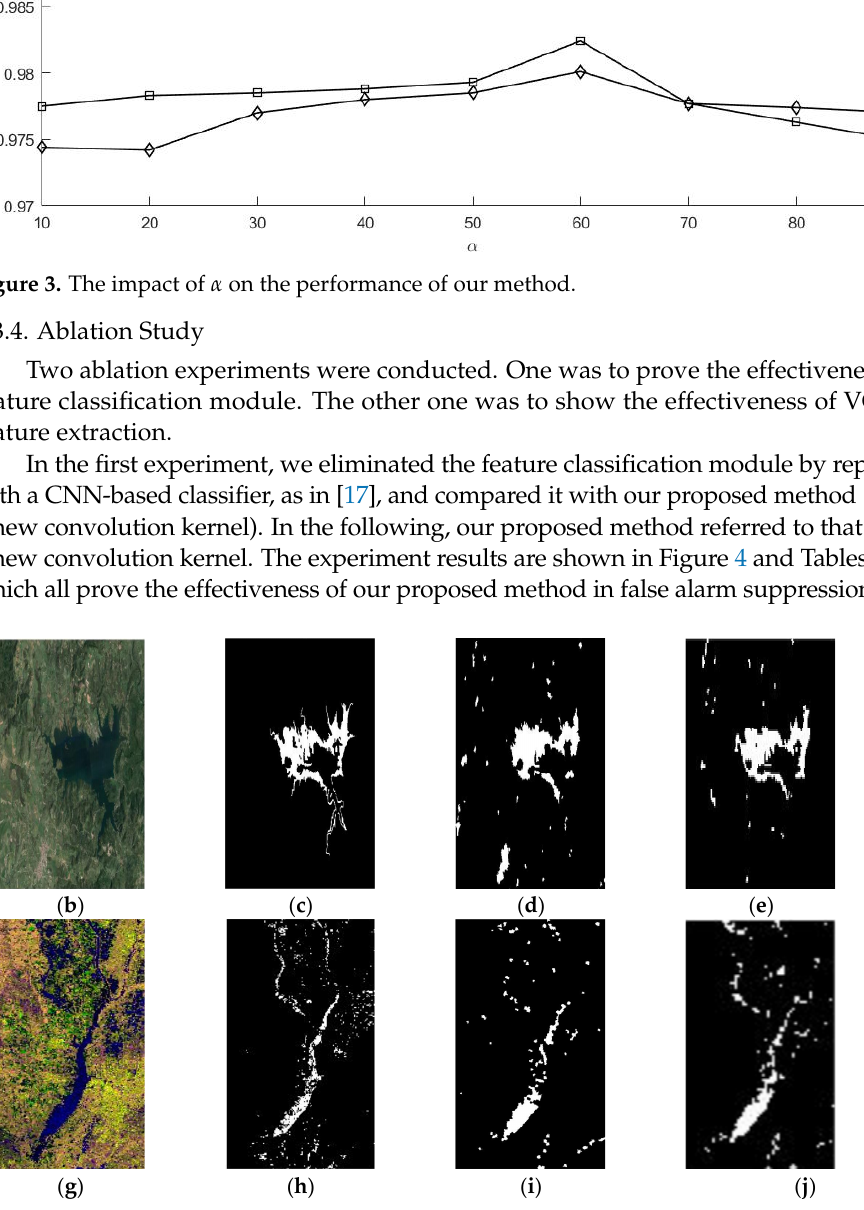
Figure 3. The impact of